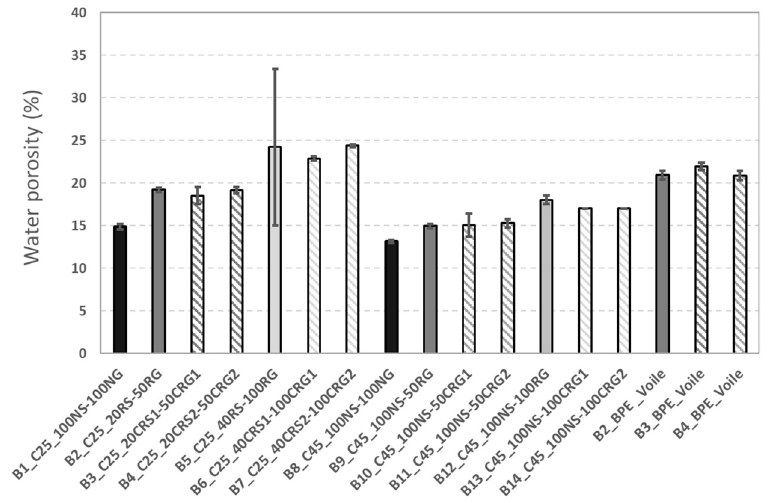
Figure 9. Water porosity.